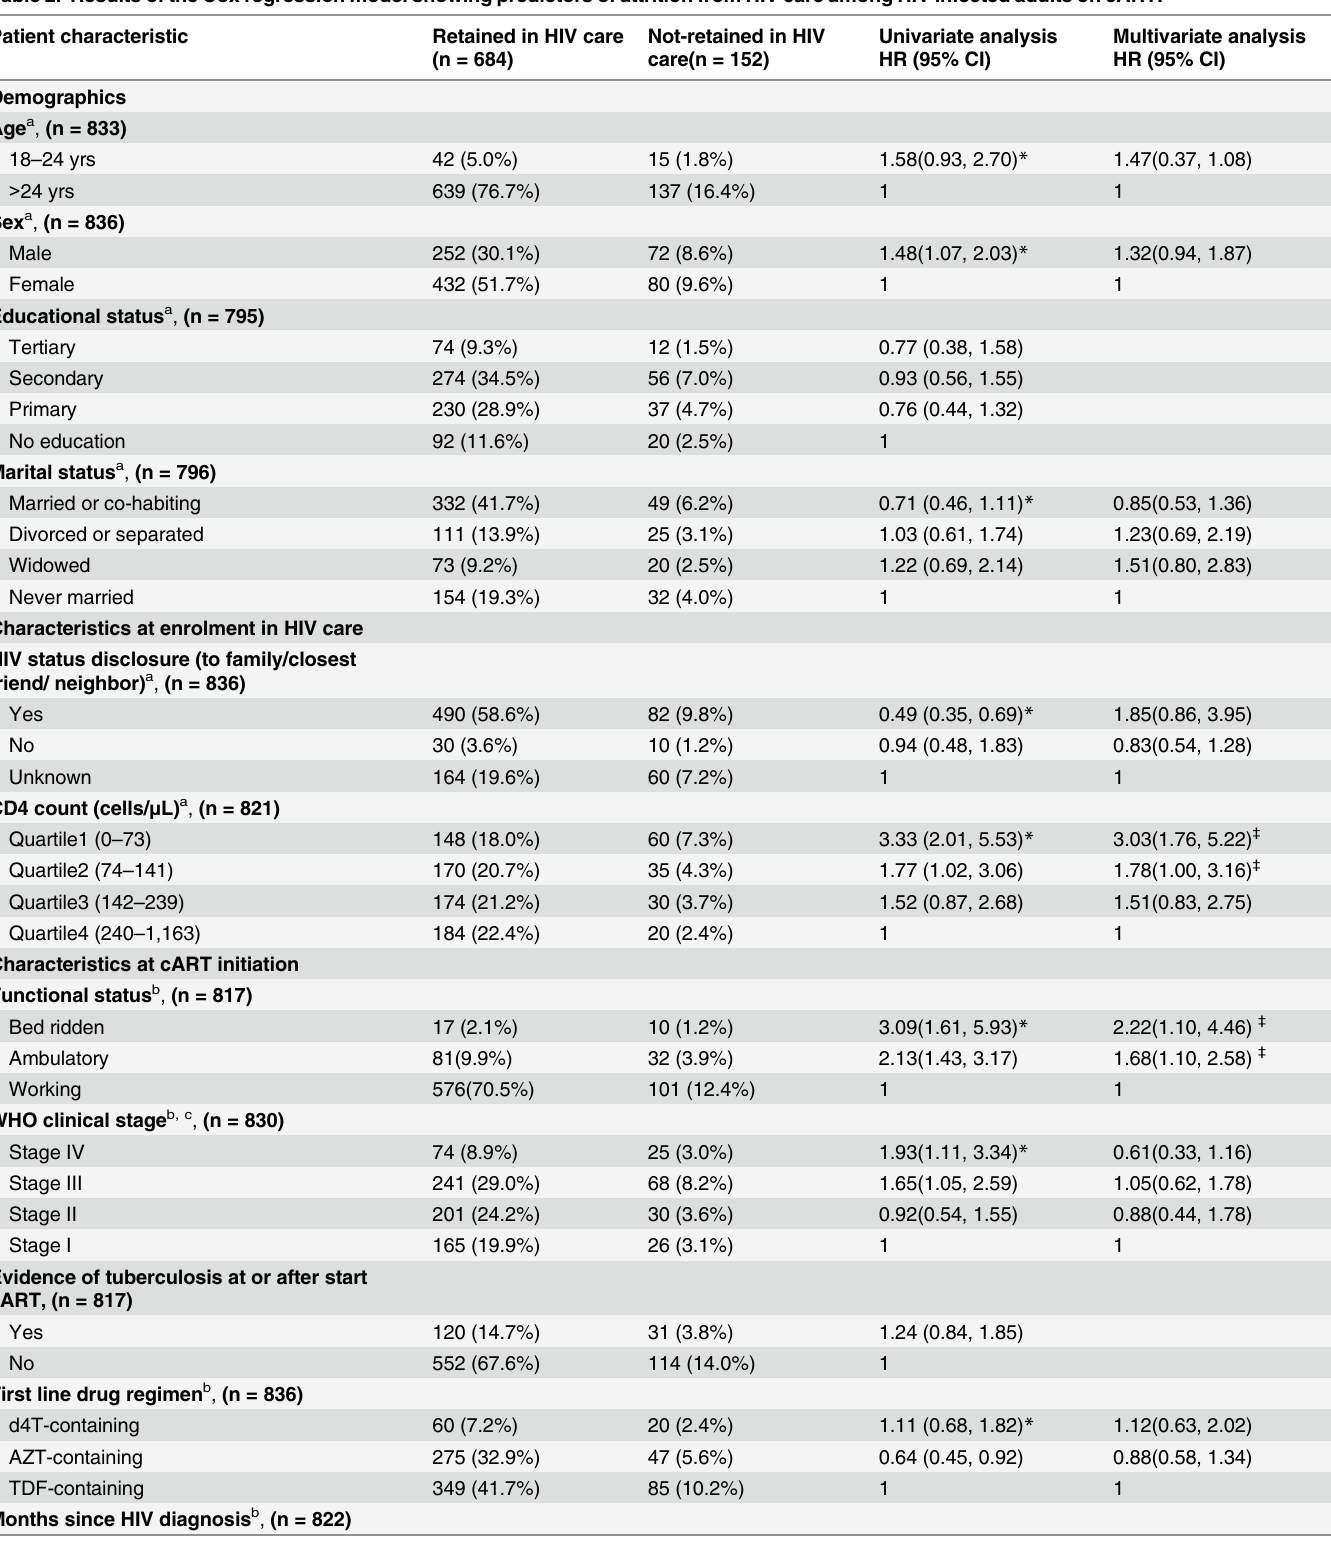
Table 2. Results of the Cox regression model showing predictors of attrition from HIV care among HIV infected adults on